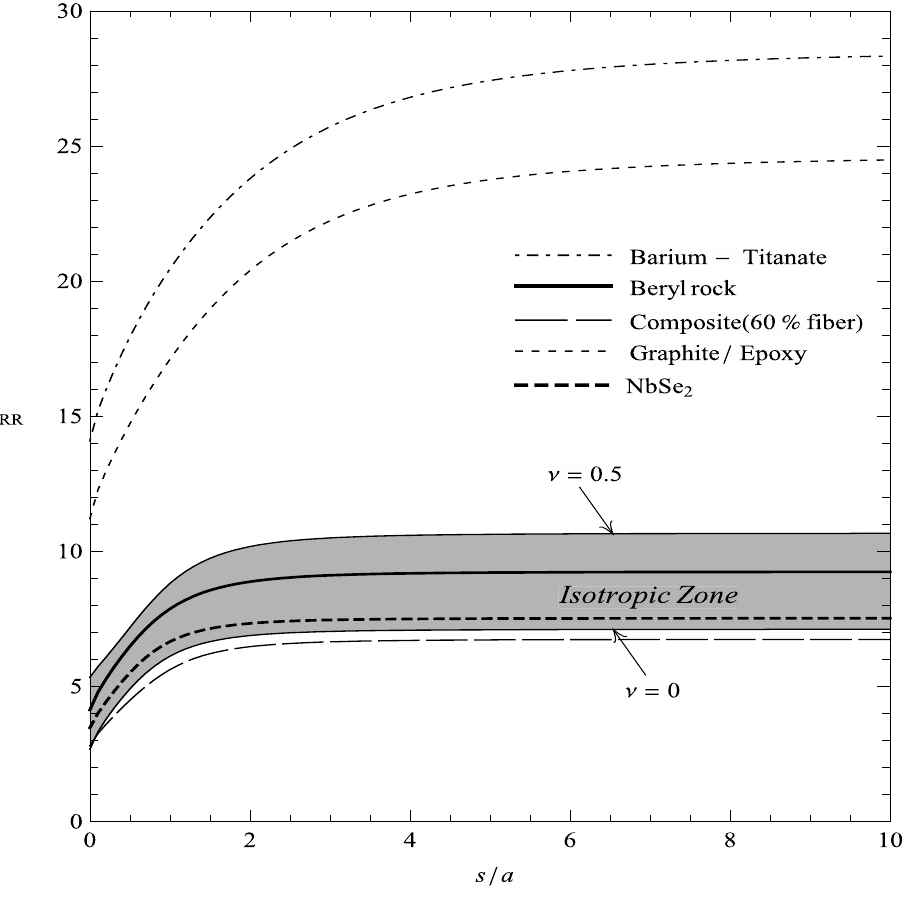
Fig. 2. Rocking stiffness vs. the rigid disk embedment depth for some transversely isotropic